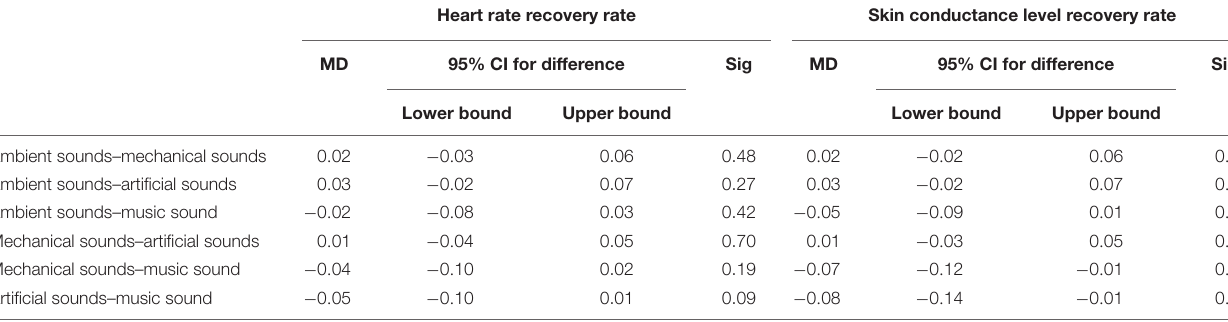
TABLE 1 | Pairwise comparison of physiological stress recovery levels in patients.